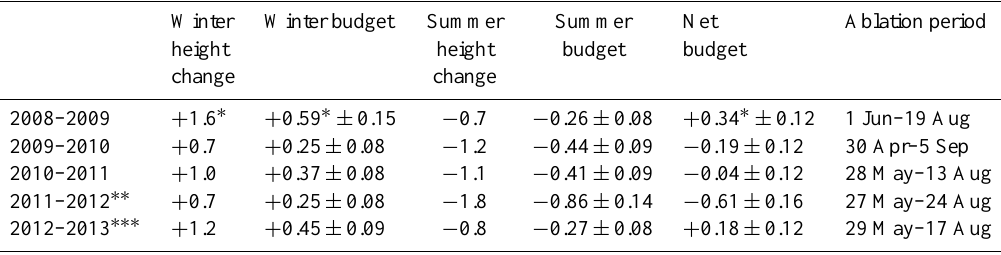
Table 4. Surface height changes and mass budgets (measured in winter and calculated in summer) at KAN_U in metres and mw.e. respec- tively and ablation duration. The uncertainty associated with surface height change is estimated to be 0.2m. The mass budgets are calculated with an assumed snow density of 360kgm − 3 (the average density of the uppermost 0.9m measured on 26 April 2013), with uncertainty estimated at 40kgm − 3 (standard deviation among the snow-pit measurements). The snow density assumption was not needed in 2012 and 2013, when actual density measurements were conducted.